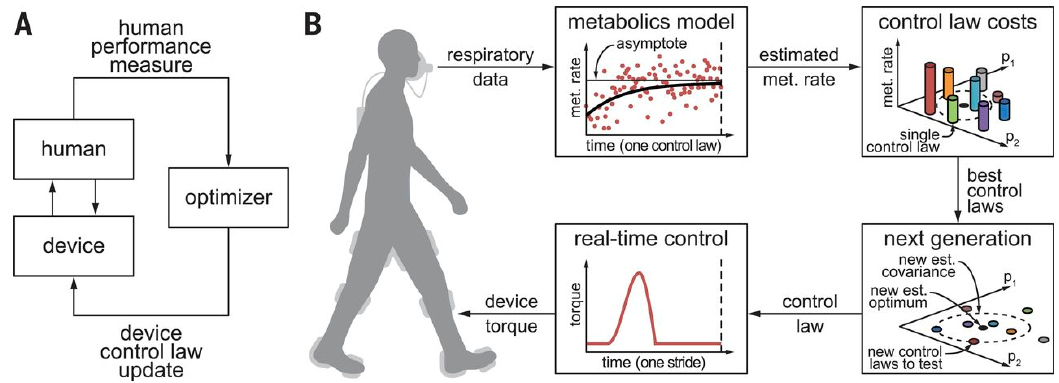
Figure 8. Human-in-the-loop optimization of exoskeleton assistance during walking ( Figure 8 was reproduced with permission from [80], Copyright Science, 2017).